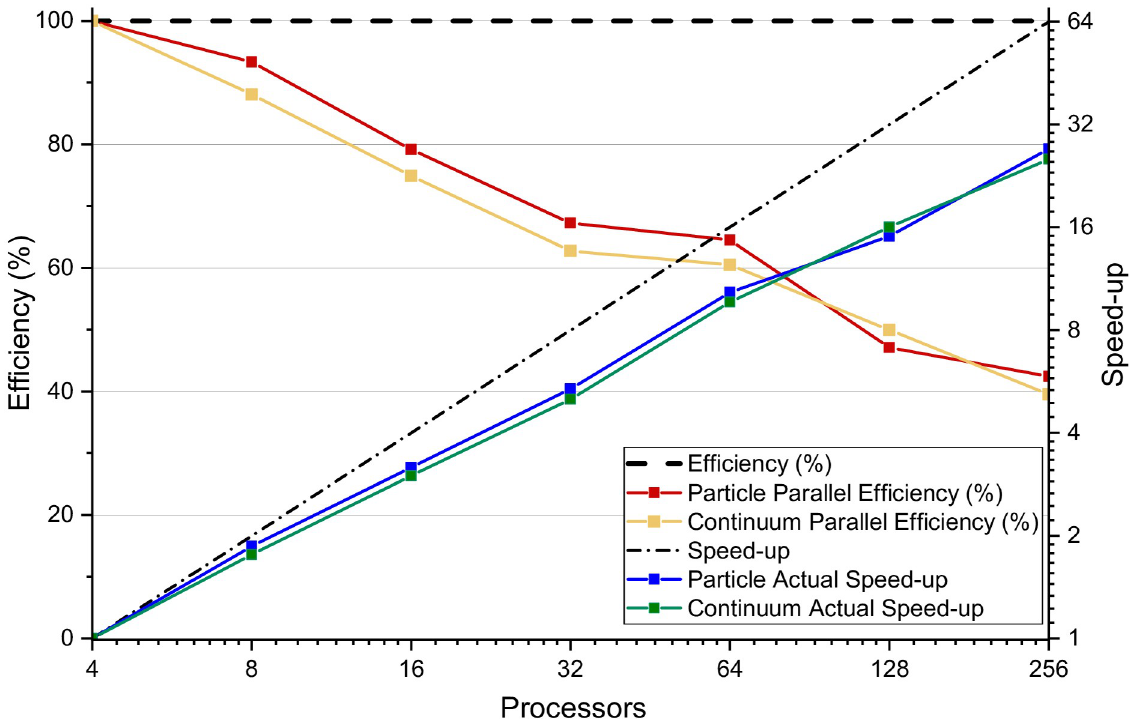
Fig 9. Performance of Case Study 2 with 4–256 processors. The initial conditions and the model parameters are kept the same in all cases. The average achieved particle number of all cases is 4.77 × 10 6 with 0.5% standard deviation. The difference is due to the randomness in sub- domains. The simulation with 4 processors is regarded as baseline case for computing speed-up. Doubling the numbers of processors results in almost double speed-up when small processor numbers are employed (e.g., less than 32). However, the speed-up and parallel efficiency decrease with increasing numbers of processors due to inter-processor